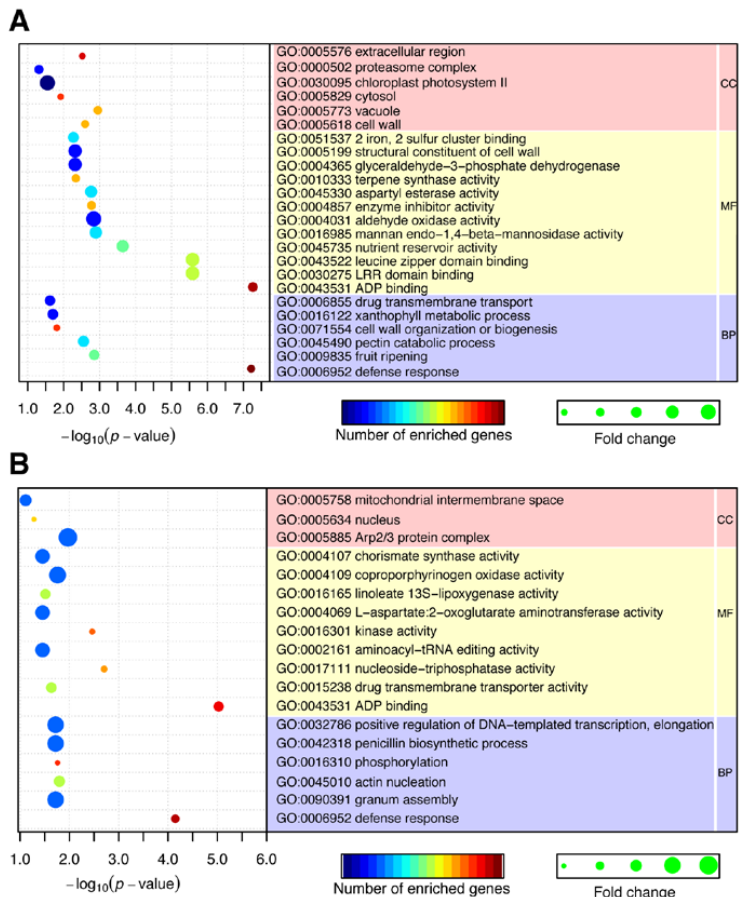
Figure 3. GO enrichment analysis of differentially expressed (DE) circRNAs. ( A ) Enriched by parental genes. ( B ) Enriched by miRNAs targeted mRNAs. GO, Gene Ontology; DE, differentially expressed; CC, cellular component; MF, molecular function; BP, biological process.